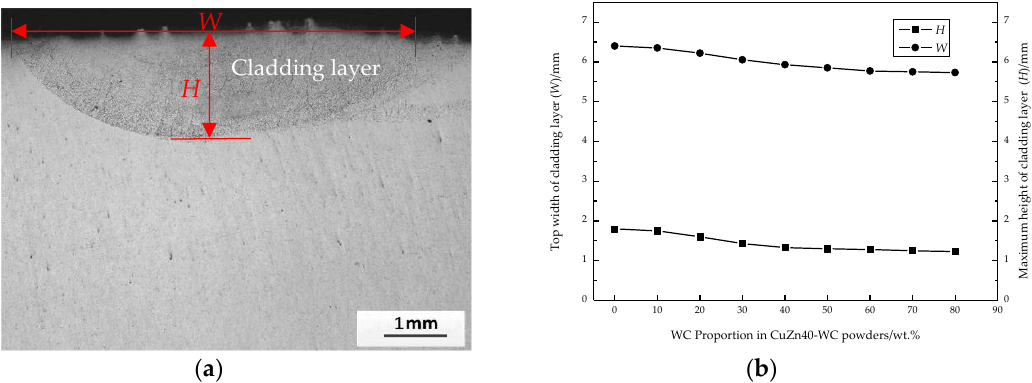
Figure 6. Morphology of the cladding layer cross-section: ( a ) Typical morphology; ( b ) effect of WC proportion in CuZn40-WC powders on cladding layer cross-section.